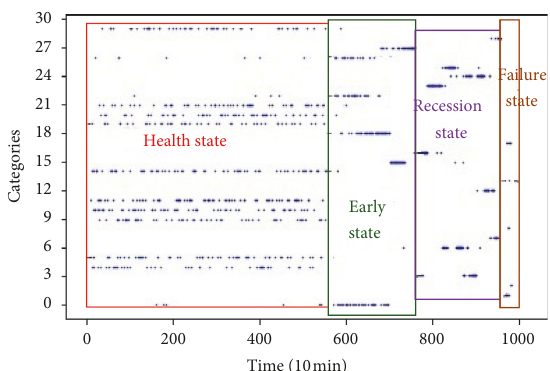
Figure 7: Cluster results of k-means.